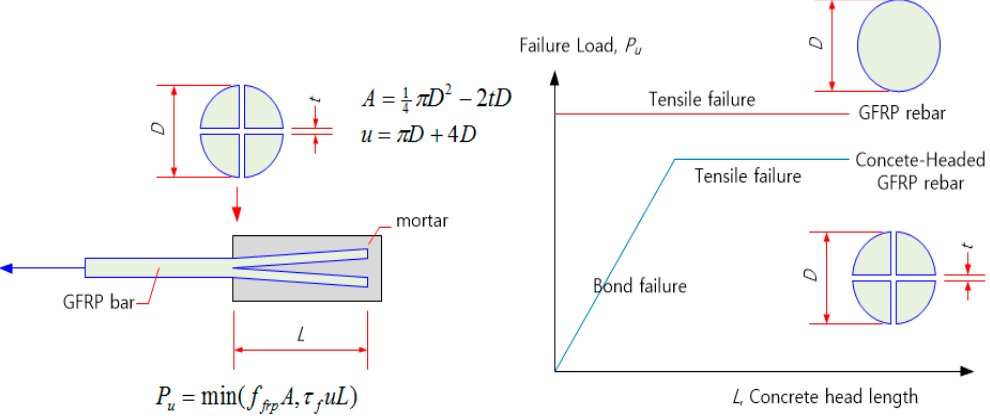
Figure 5. Schematic diagram of the failure load and failure mode.